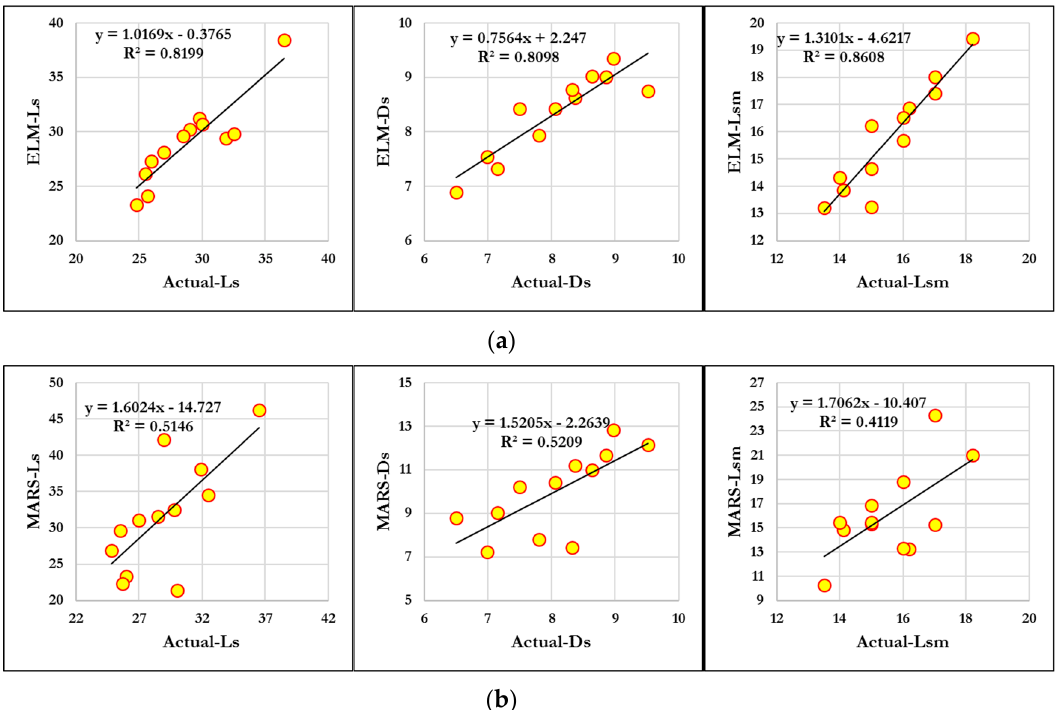
Figure 5. Scatter plots including the least square regression line and the coefficient of determination for the predicted scour-hole characteristics (Ls, Ds, Lsm) obtained using non-dimensional variables in ( a ) ELM and ( b ) MARS models.